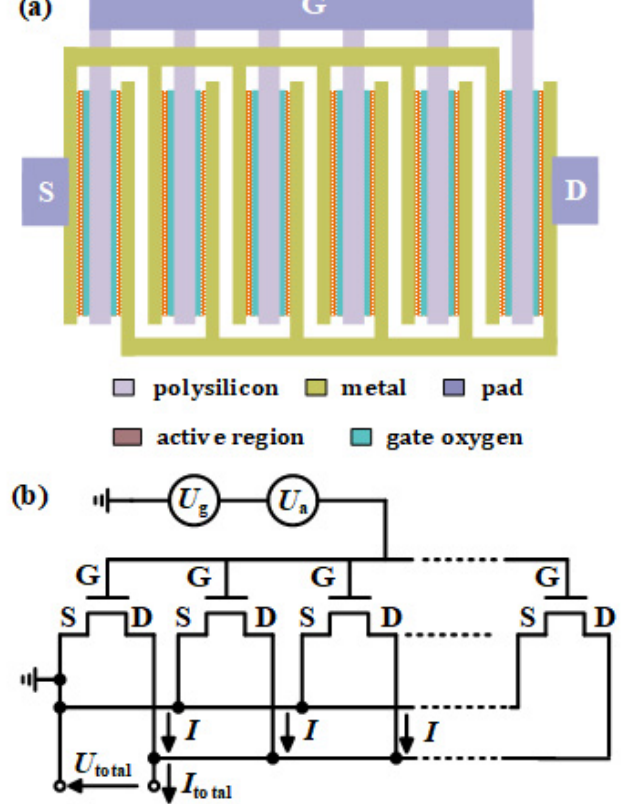
Figure 1. MOSFET array terahertz detector: ( a ) schematic diagram and ( b ) equivalent circuit model.